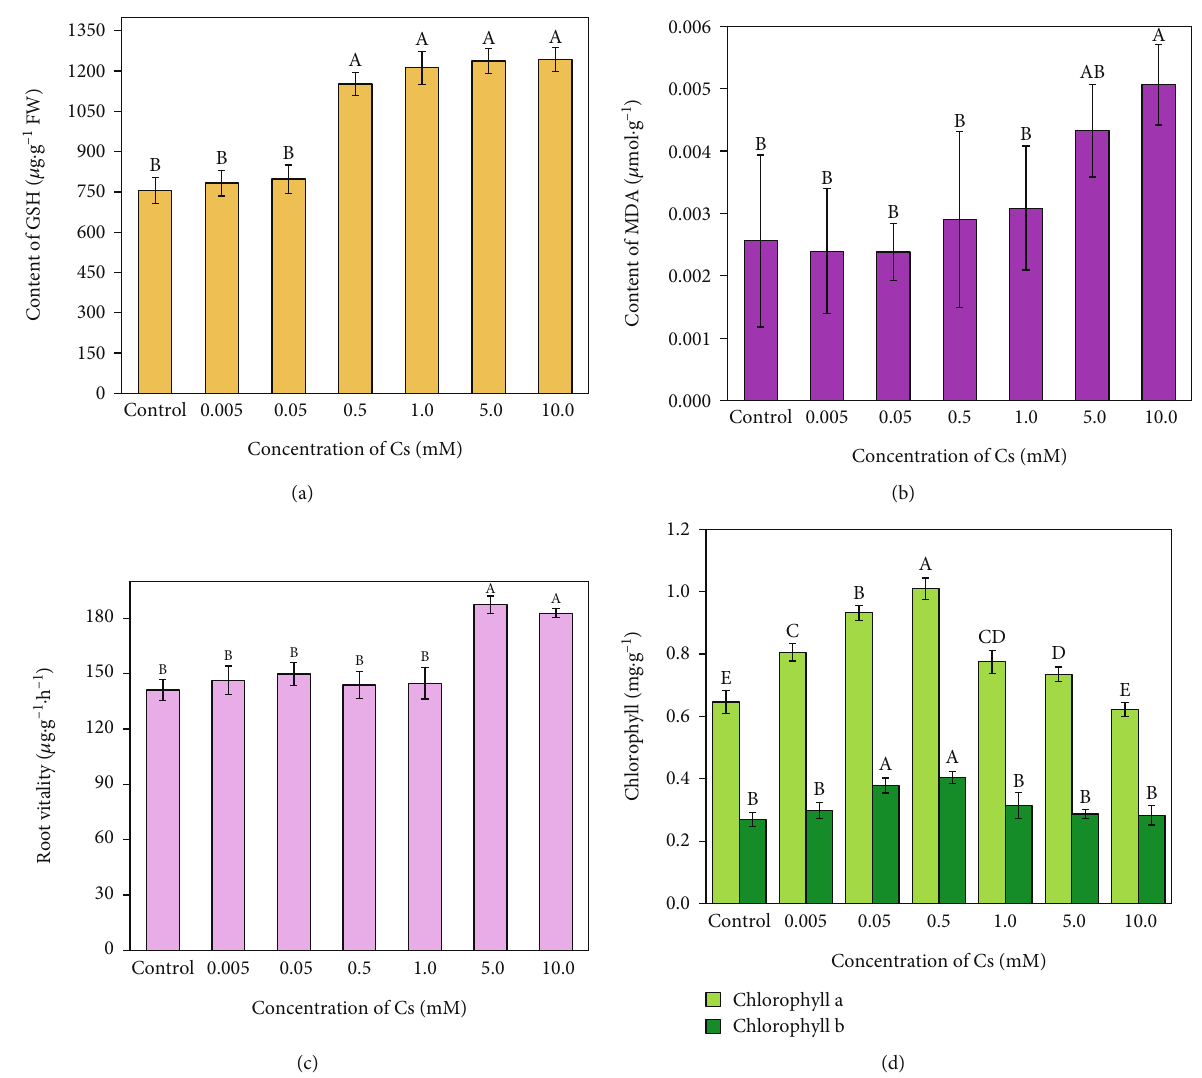
Figure 5: Response of plant physiological indicators to Cs + stress. (a – d) The contents of glutathione (GSH), malondialdehyde (MDA), root vitality, and chlorophyll a and chlorophyll b. Notes: the di ff erent lowercase letters indicate that signi fi cant di ff erences ( P < 0 : 05 ) exist between treatment groups with di ff erent Cs levels in lettuce (LSD